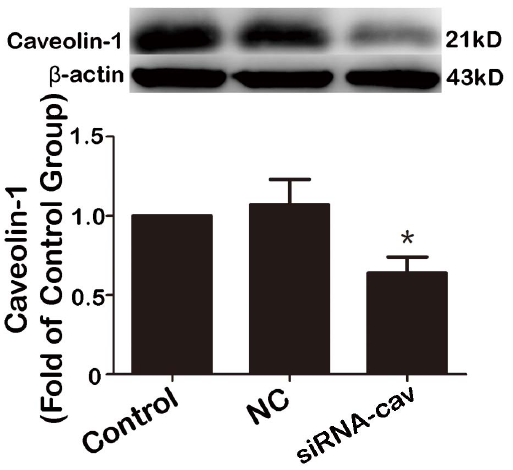
Figure 6. The siRNA of caveolin-1 suppressed the expression of caveolin-1 in HAFs. HAFs were transfected with caveolin-1 siRNA or a non-silencing negative control siRNA using Hiperfect transfection reagent following protocols provided by the manufacturer. After 48 h of incubation the cells were harvested for protein extraction. Not that the caveolin-1 siRNA suppressed the protein level of caveolin-1 by 46% compared to control group. HAFs, human atrial fibroblasts. NC, negative control, siRNA-Cav, the caveolin-1 siRNA. *P=0.035 vs. control group. n=3 per group; measurement in triplicate for each single experiment.